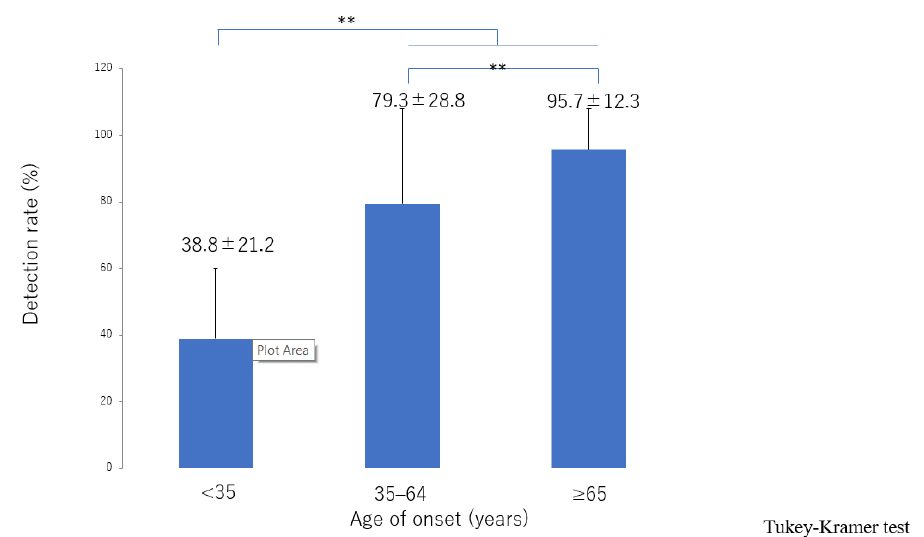
Figure 6. Lymphatic detection rate according to age of onset. The detection rate increased significantly with increasing age of onset from the <35 group, 35–64 group, through to the ≥65 group. ** p < 0.01 (Tukey–Kramer test).